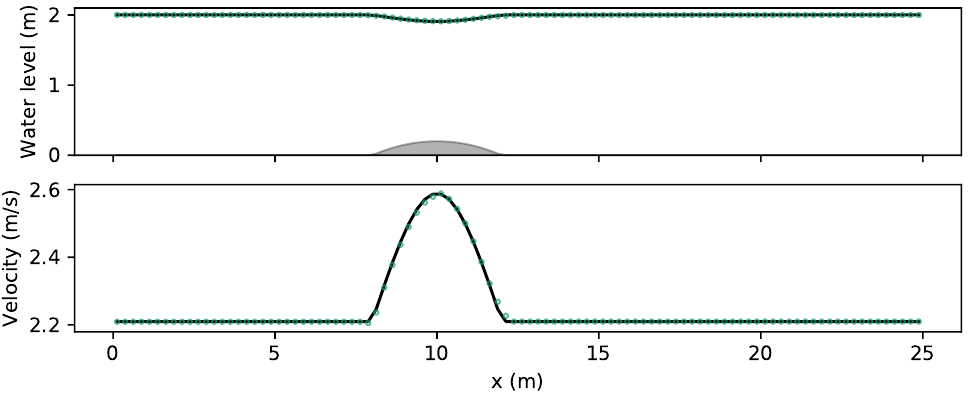
Figure 6. Analytical (black lines) and numerical (green circles) solution for subcritical flow.